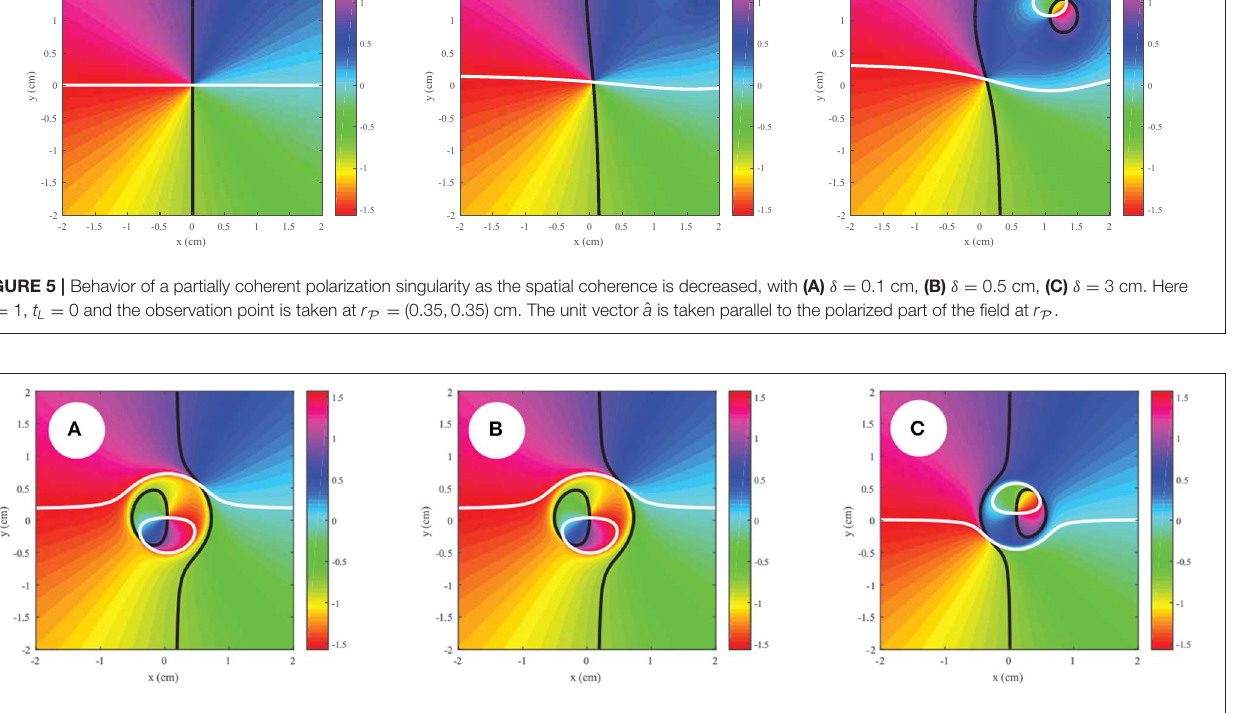
FIGURE 6 | Behavior of a partially coherent polarization singularity as the spatial coherence is decreased, with (A) δ t R 1, t L 0 and the observation point is taken at r 1 = =